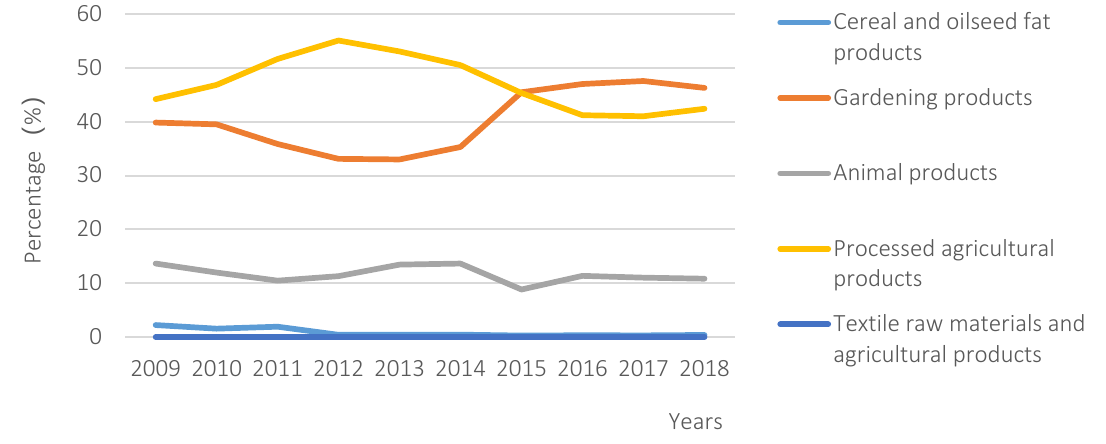
Figure 2. The proportion of China’s exports of various agricultural products to